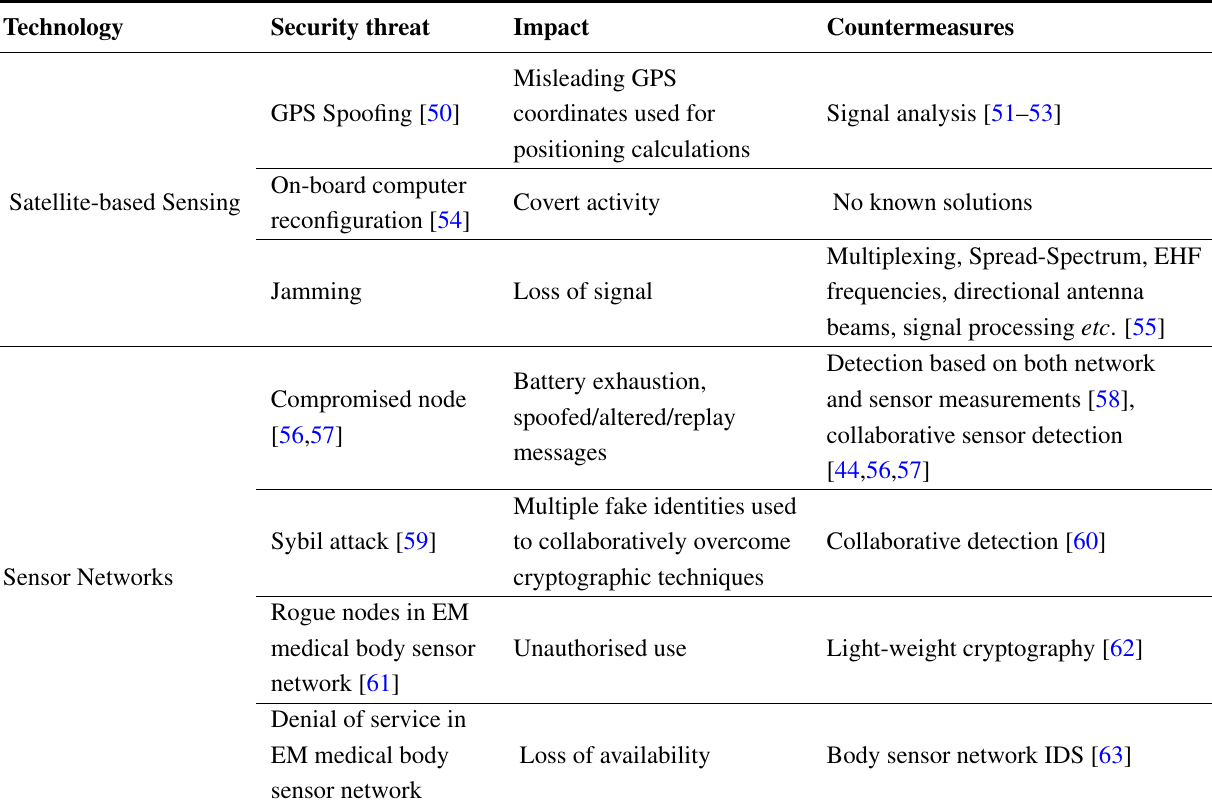
Table 2. Sensing security threats and proposed EM